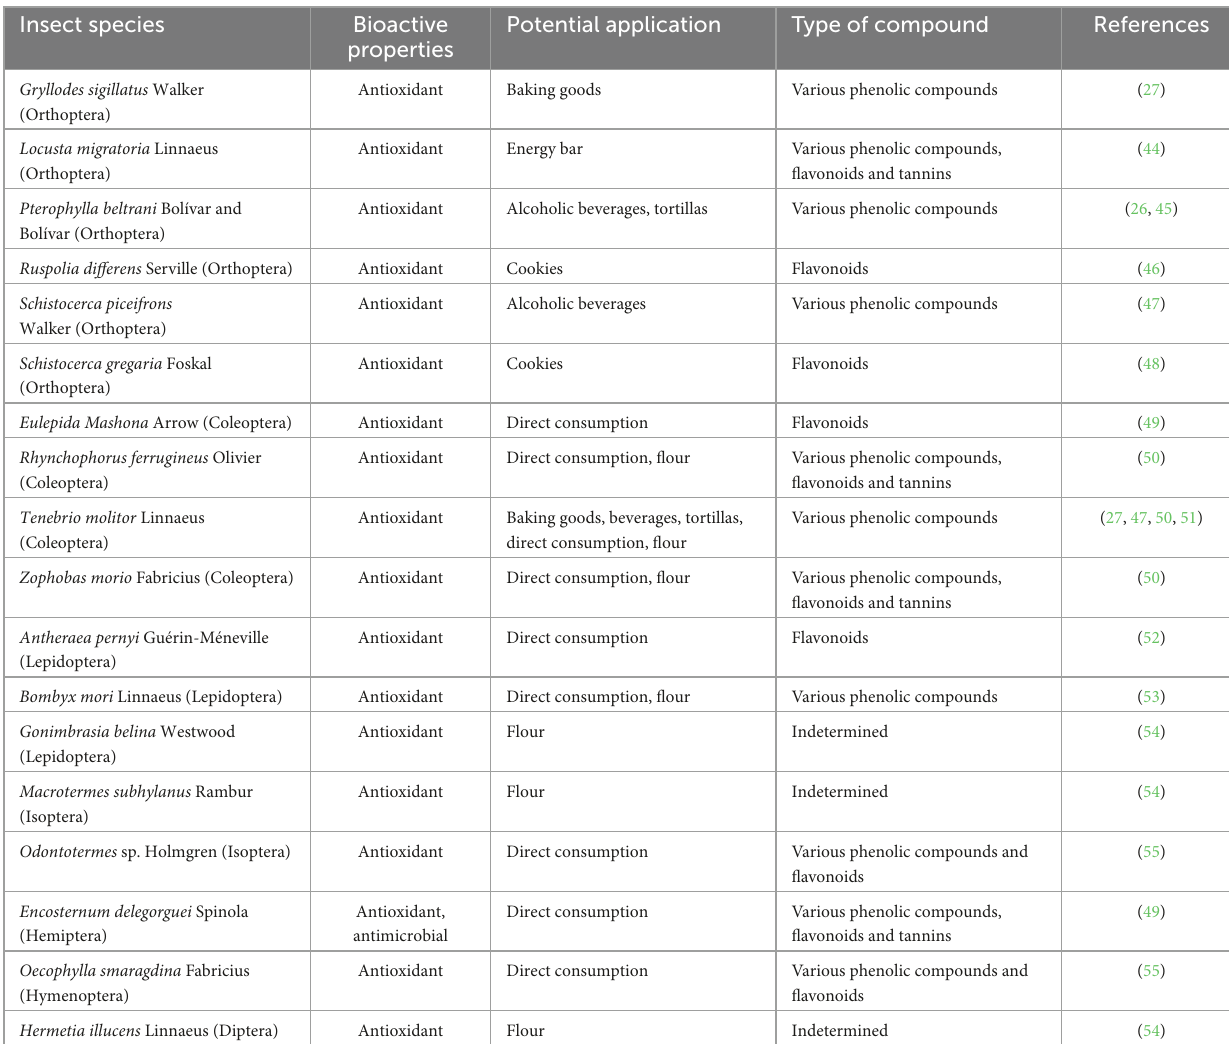
TABLE 1 Phenolic and antioxidative compounds found in insects with potential application in